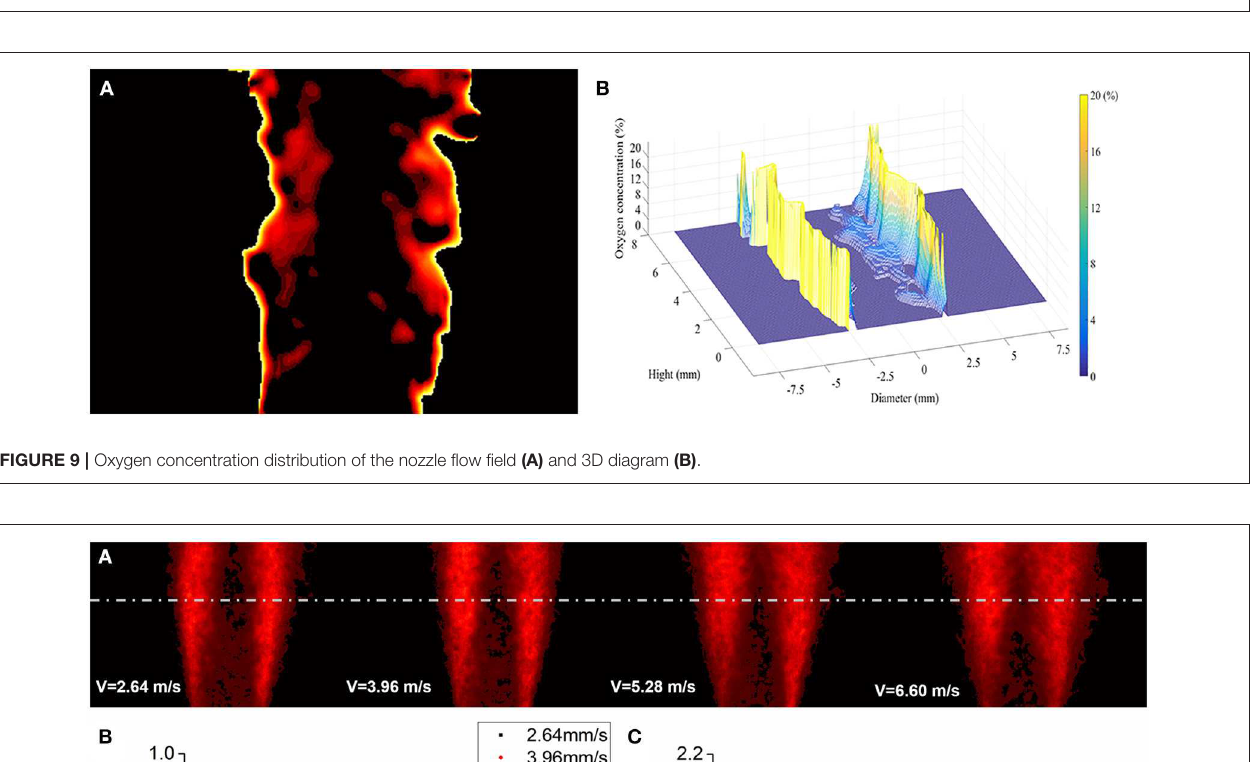
FIGURE 8 | The two-dimensional distribution of acetone (A) , toluene (B) , and the mixing area (C) .